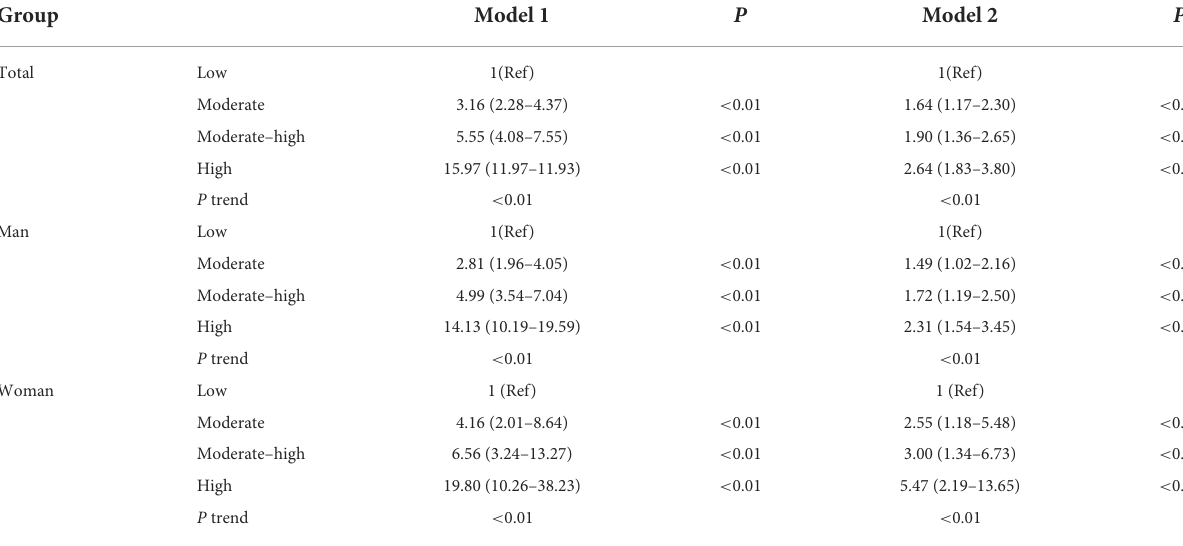
TABLE 3 Cox proportional-hazards model for AF among ePWV groups.